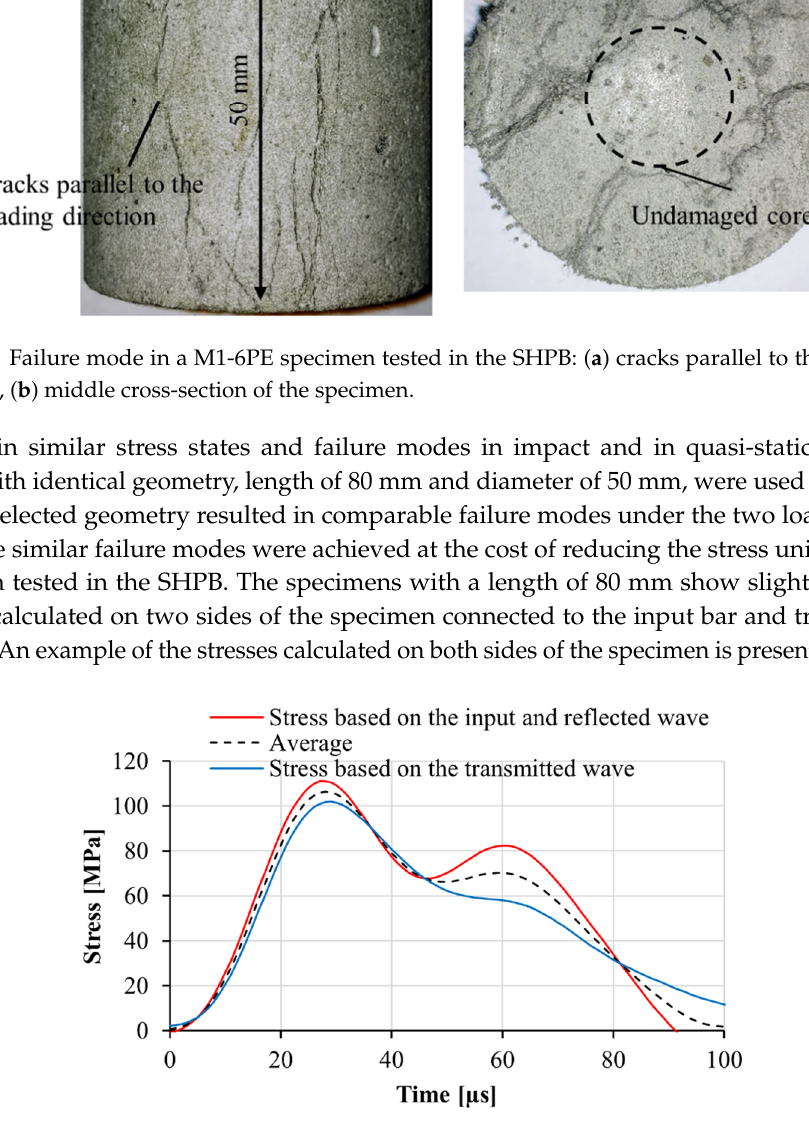
Figure 9. Failure mode in a M1-6PE specimen tested in the SHPB: ( a ) cracks parallel to the loading direction, ( b ) middle cross-section of the specimen.